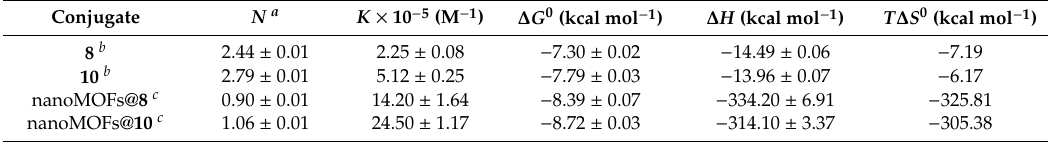
Table 1. Thermodynamics and stability constants for the binding of conjugates 8 , 10 , nanoMOFs@ 8 , and nanoMOFs@ 10 to ConA according to an n equal and independent binding sites model.